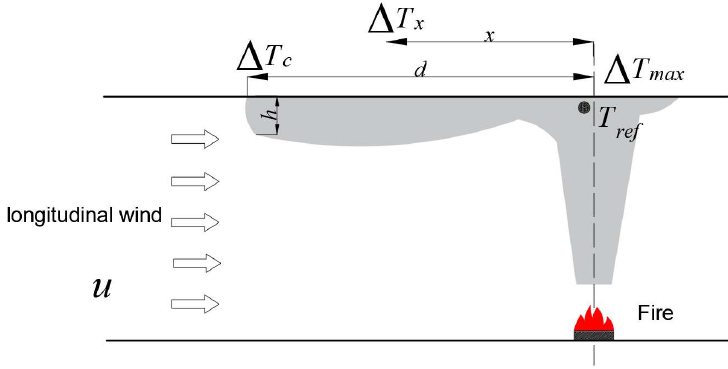
Figure 15. Theoretical modeling of smoke backflow [27].